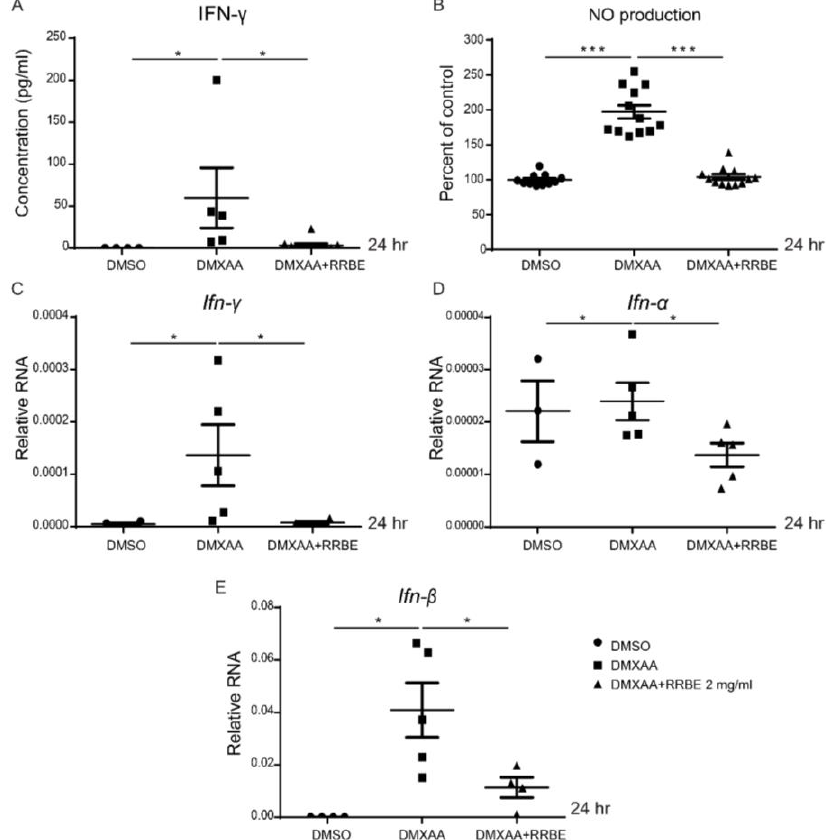
Figure 4. Effects of RRBE on the production of IFN- γ and nitric oxide. ( A ) Supernatants were collected, and we determined the concentration of IFN- γ after DMXAA with and without RRBE for 24 h by ELISA (N = 4 – 7). ( B ) Nitric oxide (NO) production was determined by the Griess assay (N = 7 to 10 per group). The mRNA expression (normalized by actin) of ( C ) Ifn- γ , ( D ) Ifn- α and ( E ) Ifn- β are shown. Data are shown as mean ± SEM, * p < 0.05, and *** p < 0.001.